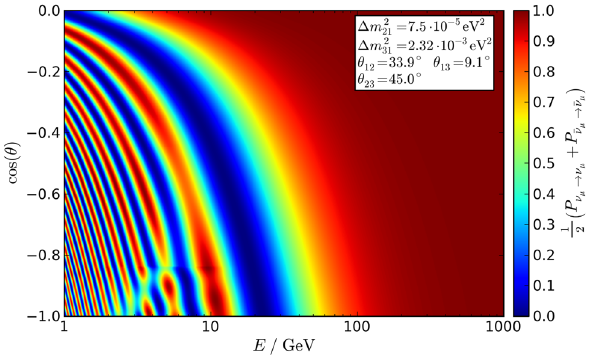
Fig. 5 The survival probability of muon neutrinos (averaged over ν μ and ν μ ) as a function of zenith angle and energy. Figure from Ref. [68]